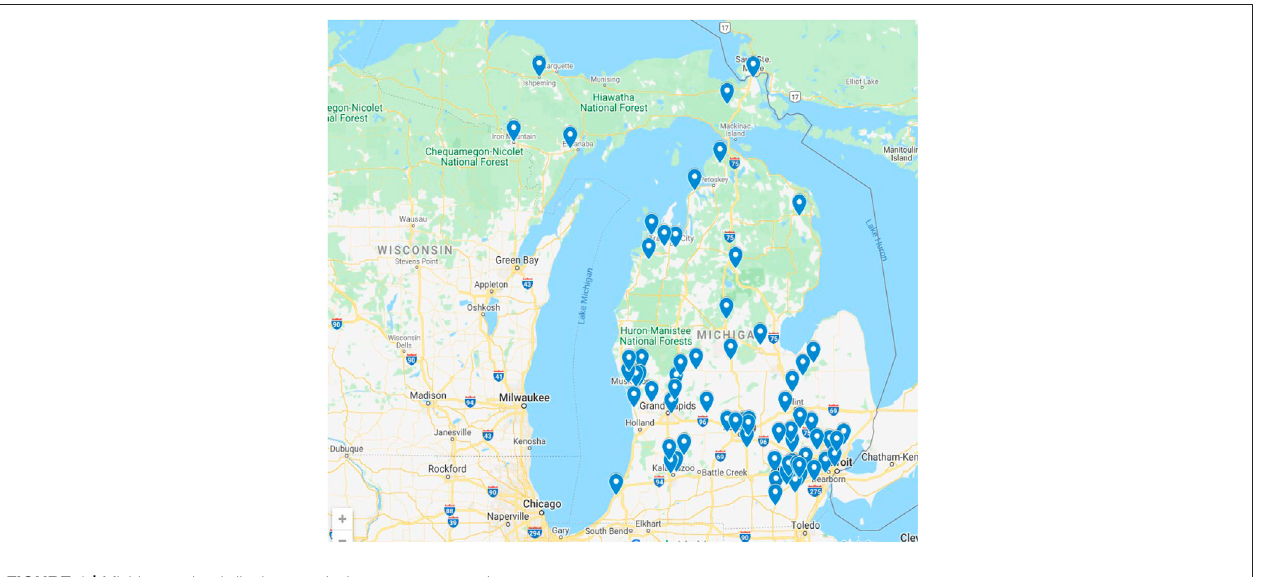
FIGURE 1 | Michigan school districts employing survey respondents. Note : Survey question: “ In what school district are you employed? ”